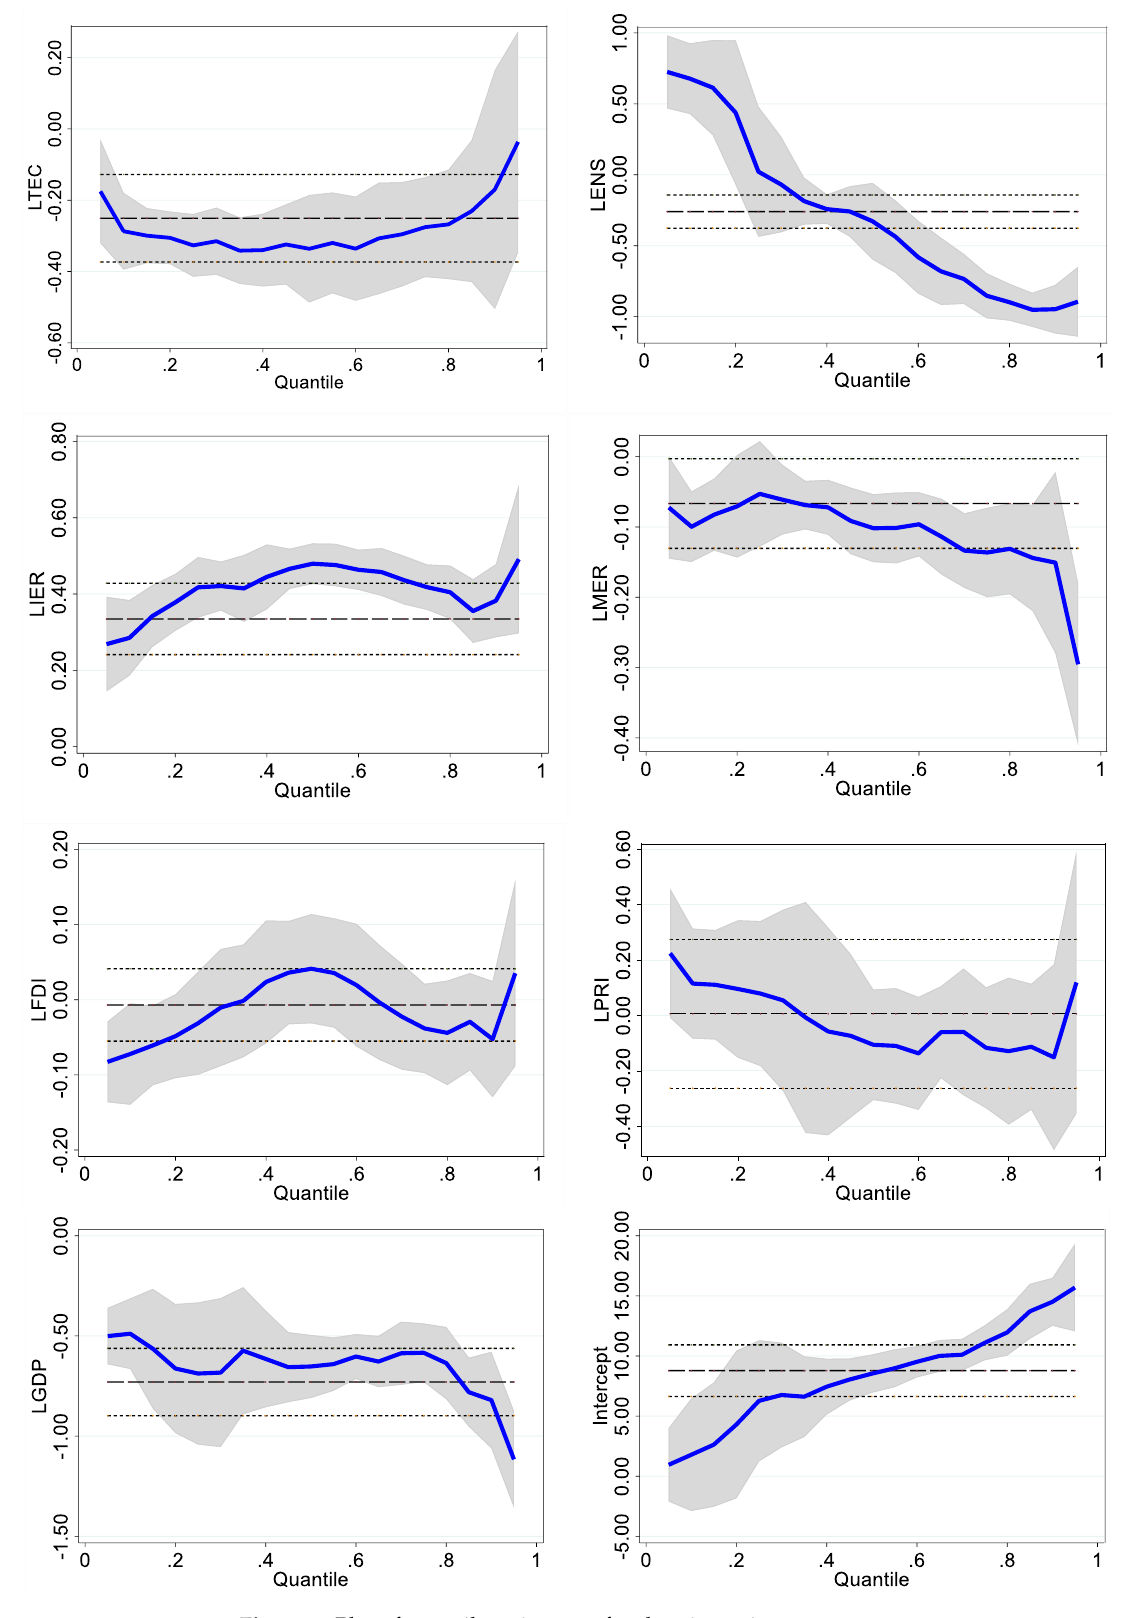
Figure 2. Plot of quantile estimates of carbon intensity.